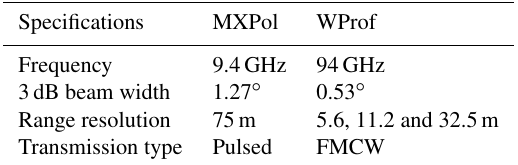
Table 2. Specifications of MXPol and